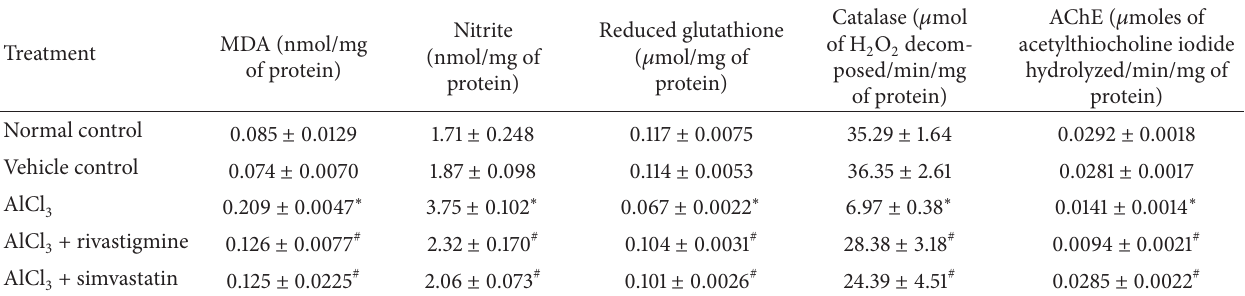
-induced biochemical changes on frontal cortex. 3